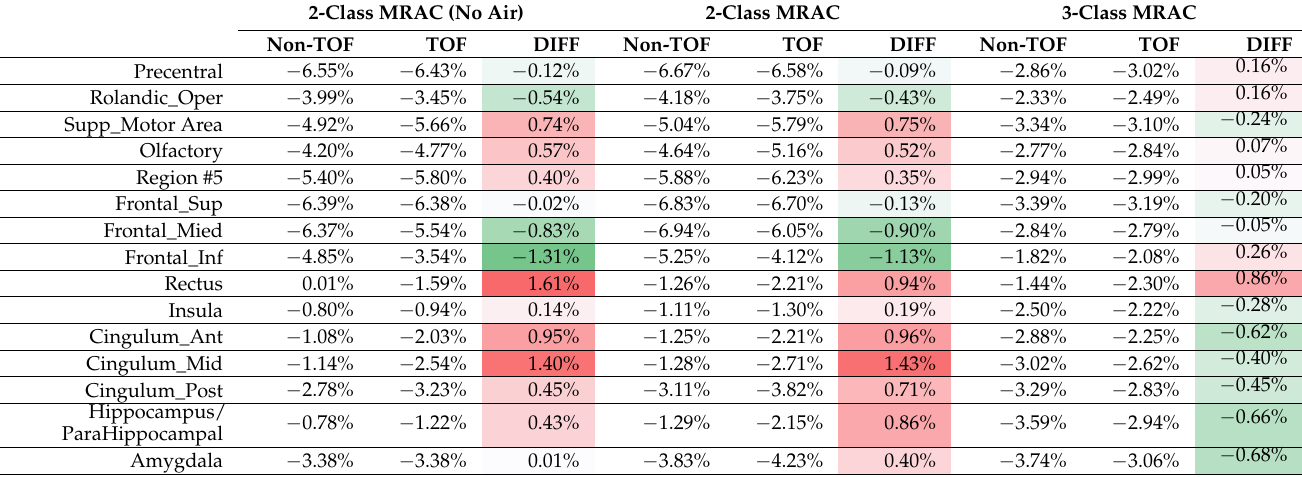
Table A1. The mean of the bias across the brain regions with all attenuation maps with TOF and non-TOF reconstructions. The color of the DIFF column indicates the direction of the change. Green comparisons improve, and red comparisons get larger